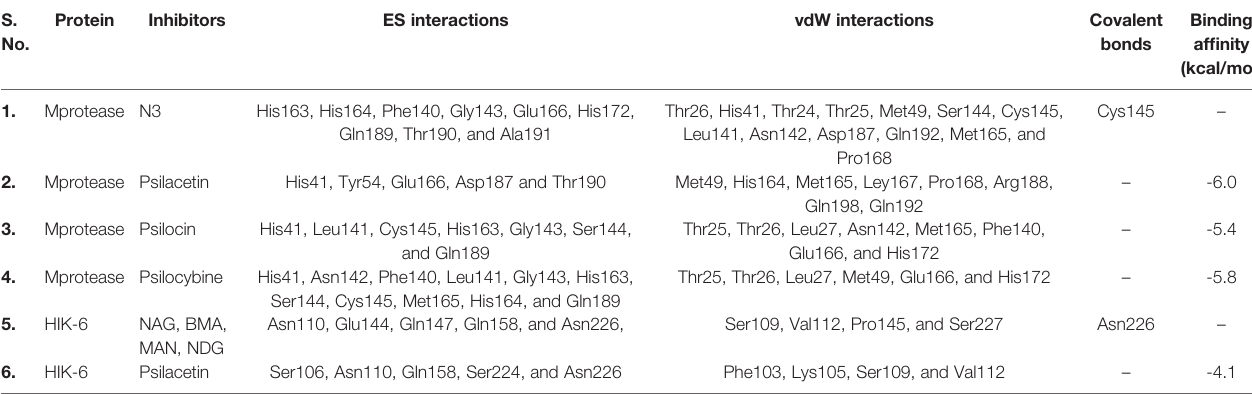
TABLE 2 | The ES, vdW and covalent interactions of inhibitor N3, psilacetin, psilocin, and psilocybine with SARS-CoV-2 Mprotease. S.